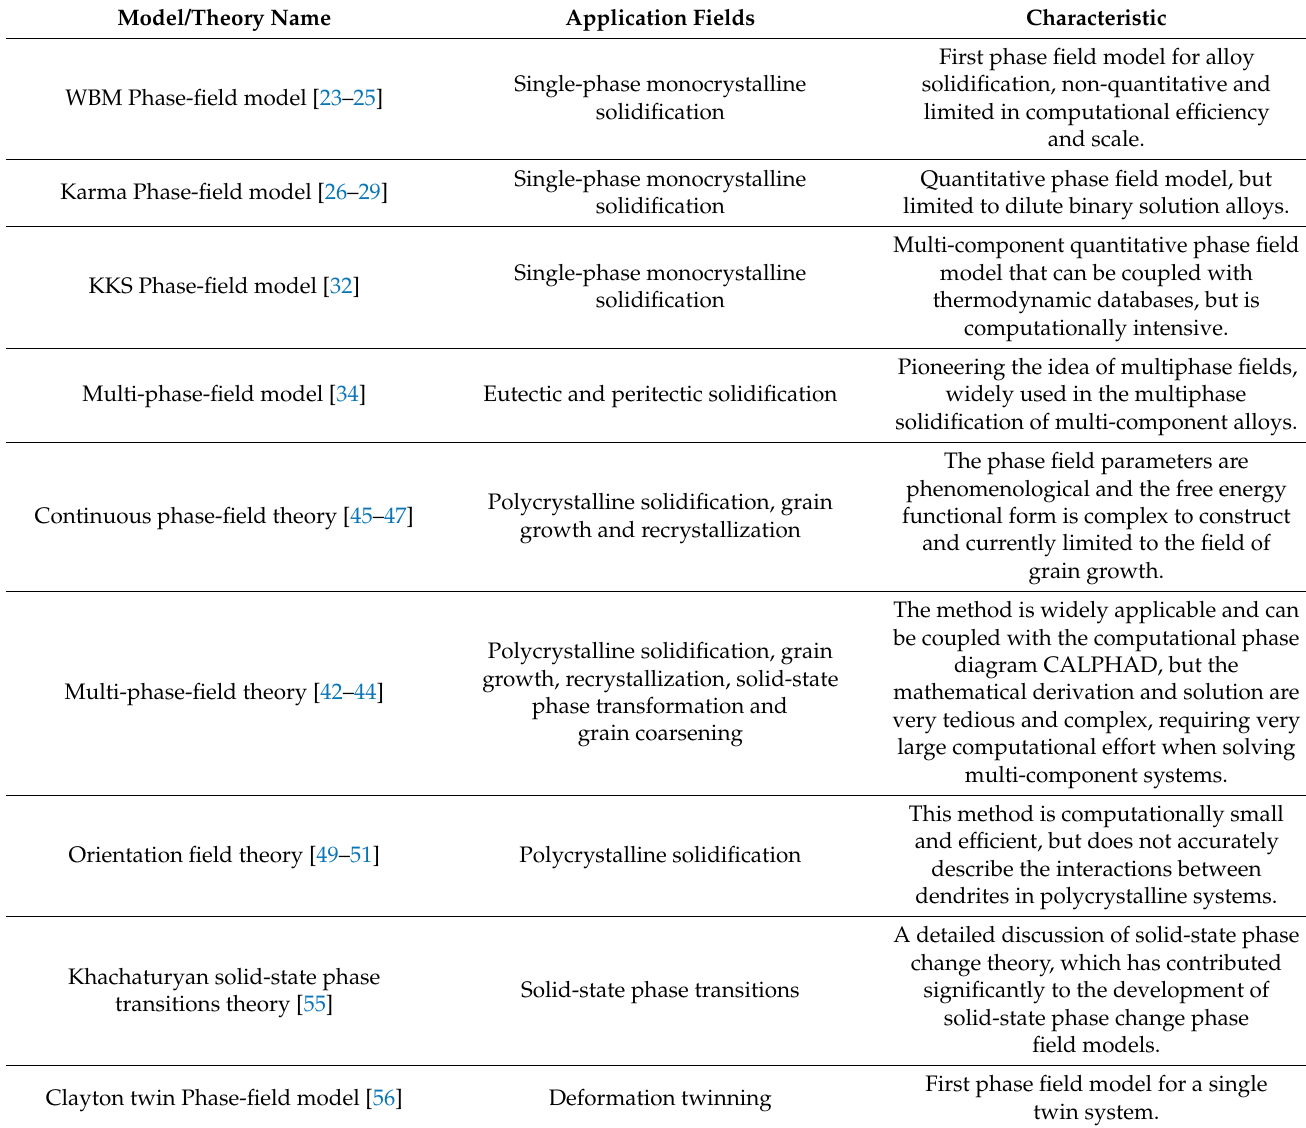
Table 1. Summary of phase-field